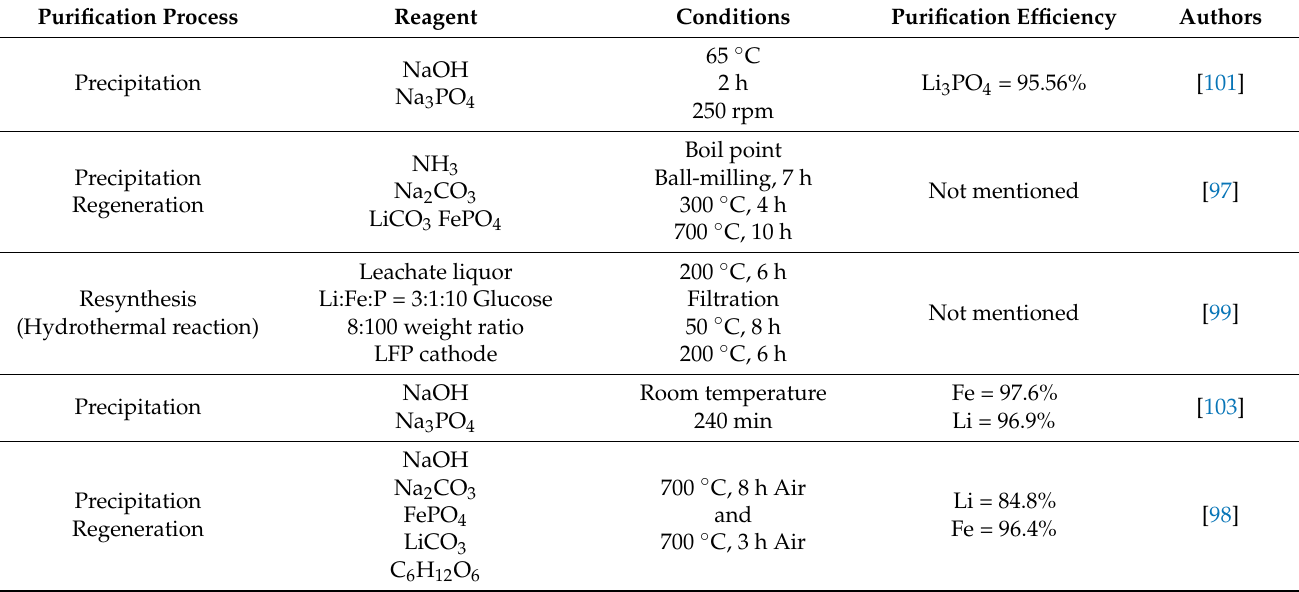
Table 5. Organic acids leaching of LFP